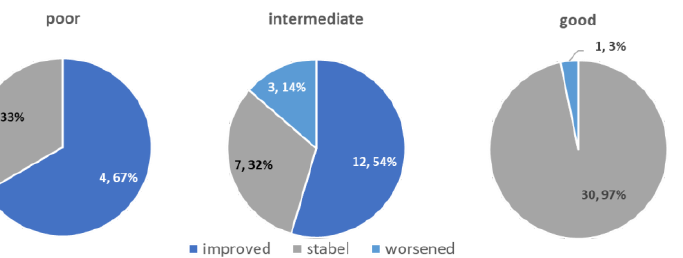
Figure 4. Post-P-MCP treatment change of PSADT in different pre-treatment PSADT risk groups ( n ,